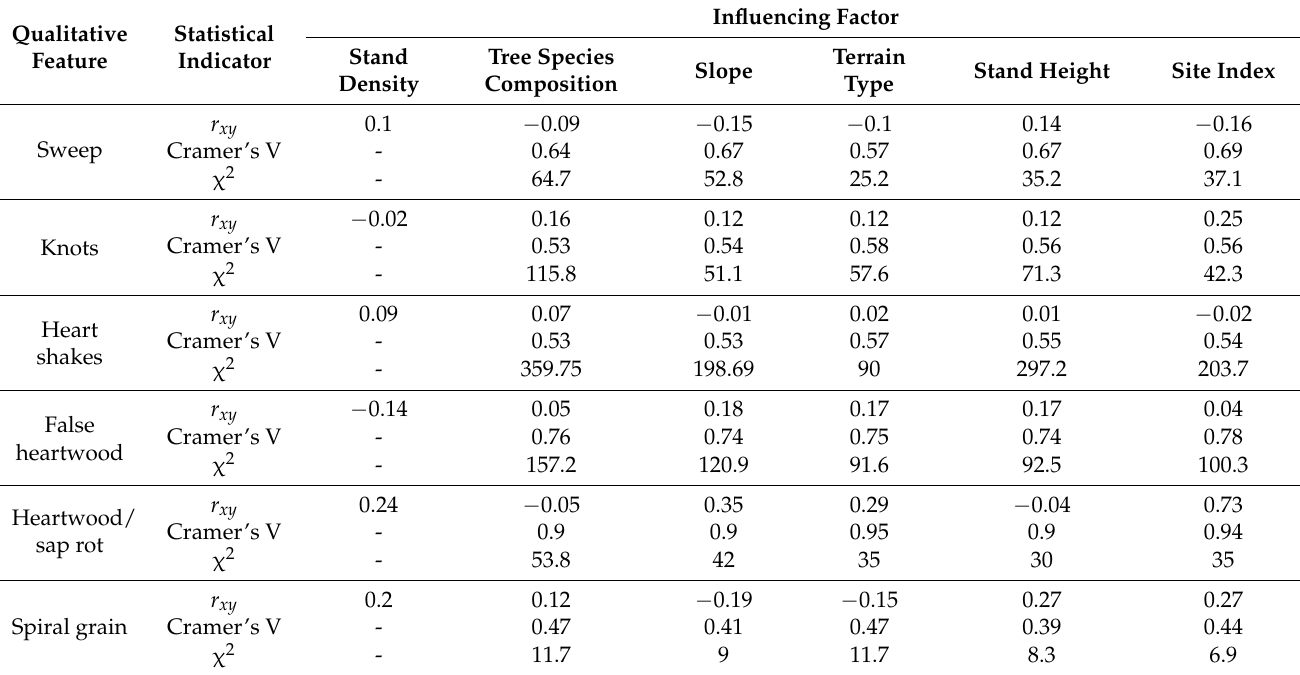
Table 2. Statistical dependence of the size of individual qualitative features of beech trunks on selected factors in individual forest